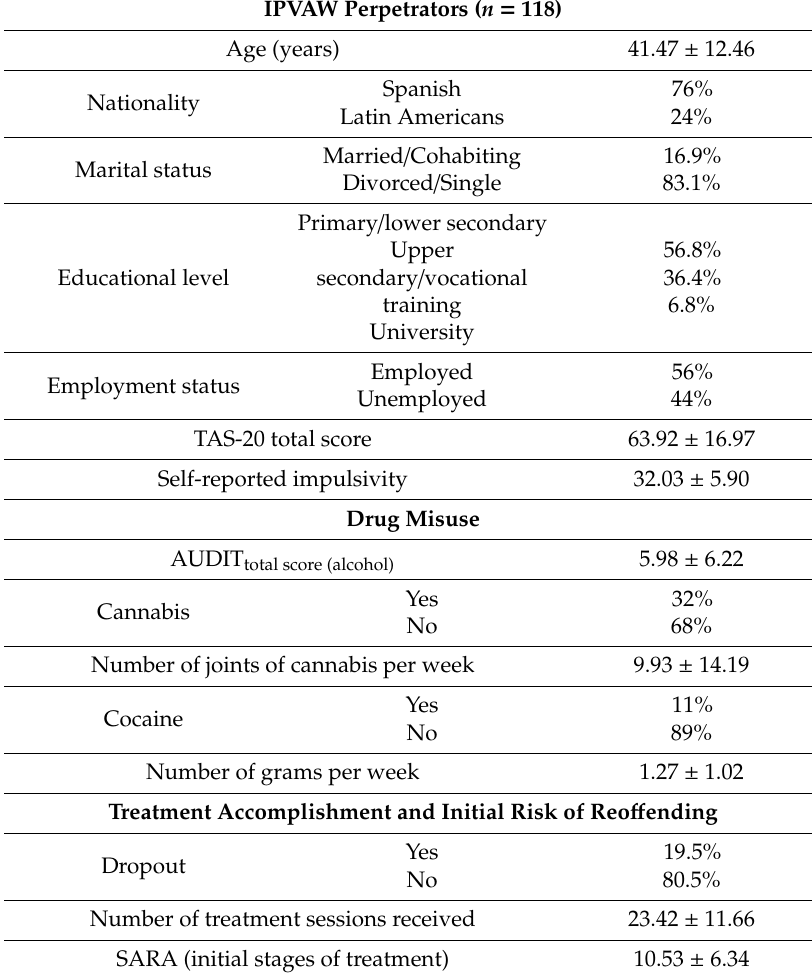
Table 1. Mean + SD and percentages of socio-demographic and drug use variables of